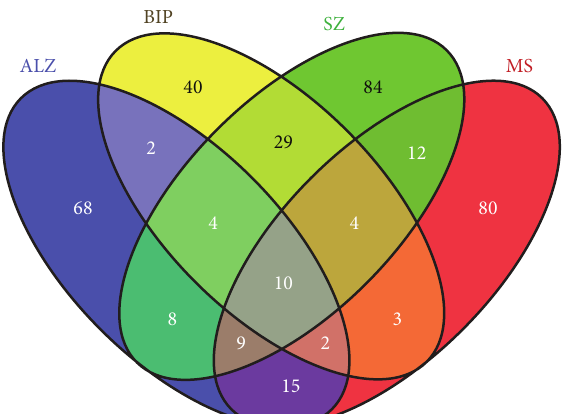
Figure 1: The Venn diagram illustrates the number of susceptibility genes (all within the 𝑇 . gondii /host interactome) that are common or specific to various permutations of Alzheimer’s disease (Alz), Bipolar disorder (Bip) Schizophrenia (SZ) ormultiple sclerosis (MS) (see Table 4 for genes in each